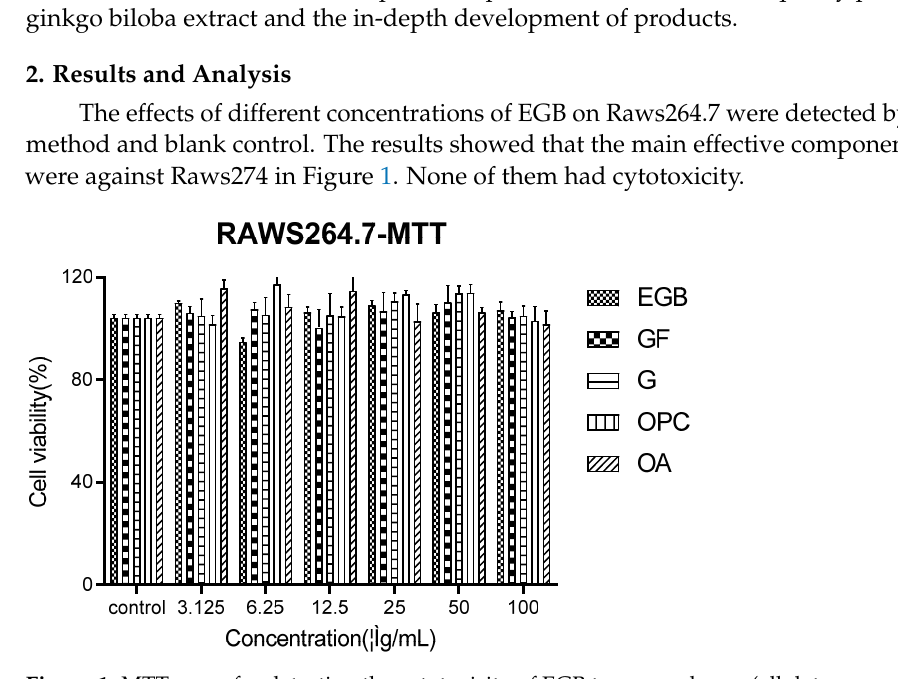
Figure 1. MTT assay for detecting the cytotoxicity of EGB to macrophages (all data were mean ( ± SD) of three independent experiments). G is the ginkgolide abbreviation, OPC is proanthocyanidins, OA is organic acids, and GF is ginkgo flavonoids.